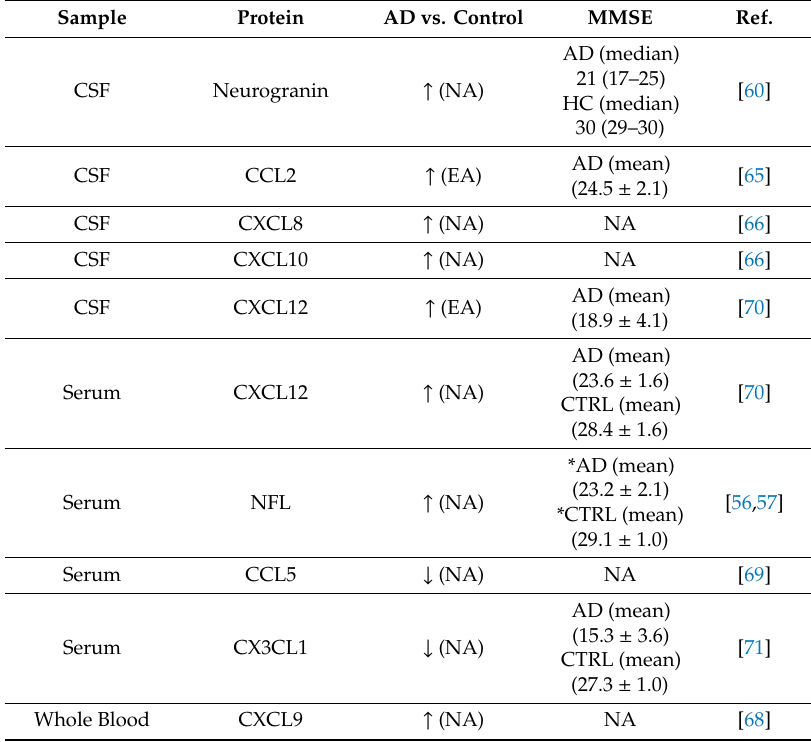
Table 1. Promising Alzheimer’s disease biomarkers variations. EA = AD early stage, NA = Not available information about the stage of the disease or MMSE. *